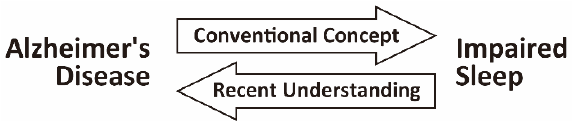
Figure 1. Bidirectional relationship between Alzheimer’s disease (AD) and impaired sleep. Impaired sleep is prevalent in patients with AD. Both epidemiological and experimental studies have led to the recent concept of a bidirectional relationship between AD and impaired sleep. In addition to the conventional concept that impaired sleep is a consequence of AD pathology affecting brain regions regulating the sleep–wake or circadian rhythm, impaired sleep has been suggested as a risk factor for the initiation and progression of AD.